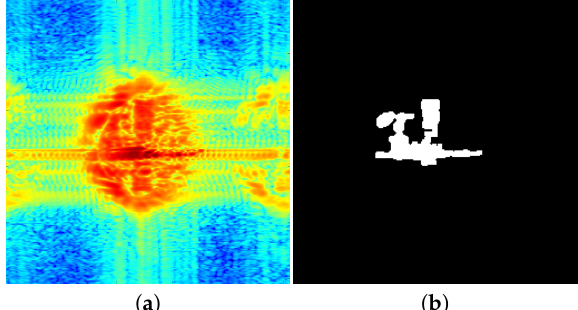
Figure 25. Misclassified image of knife: ( a ) RGB mmW scan; ( b ) Segmented image.